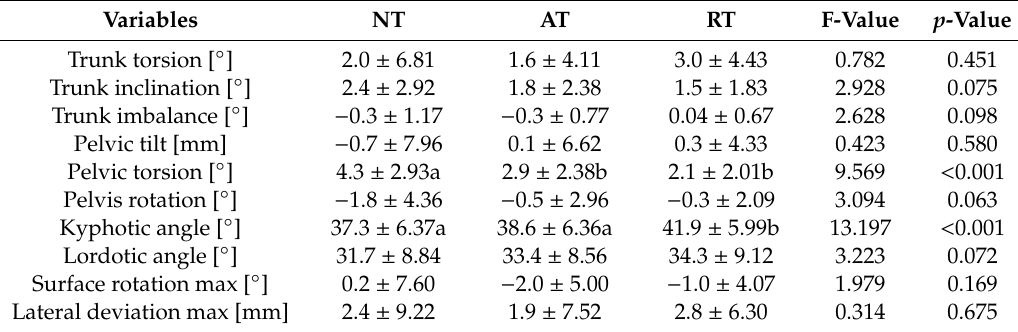
Table 2. Changes in body alignment condition (mean ± SD).